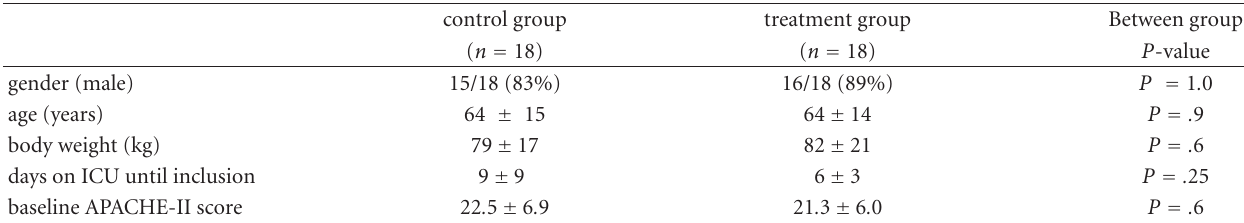
Table 1: Characterisation of the study cohort.